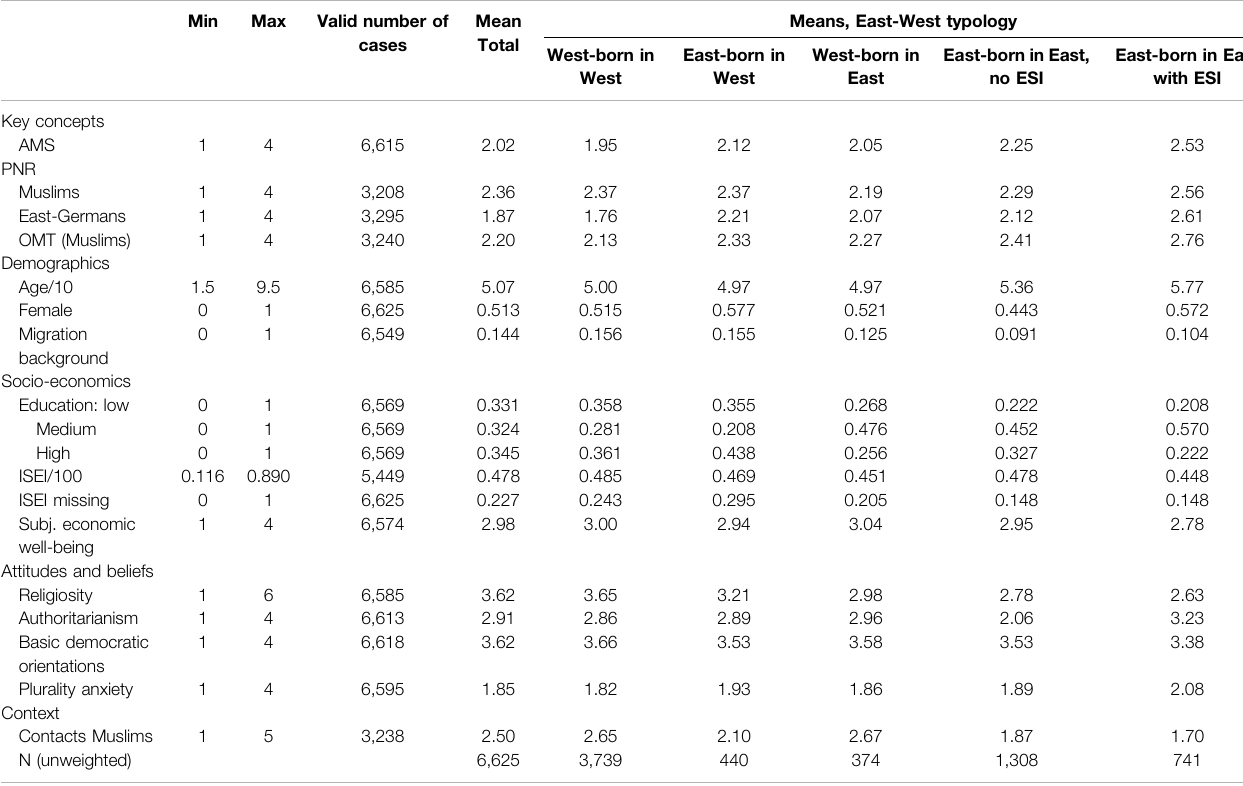
Table 1 | Descriptives (weighted means or mean shares) of variables used